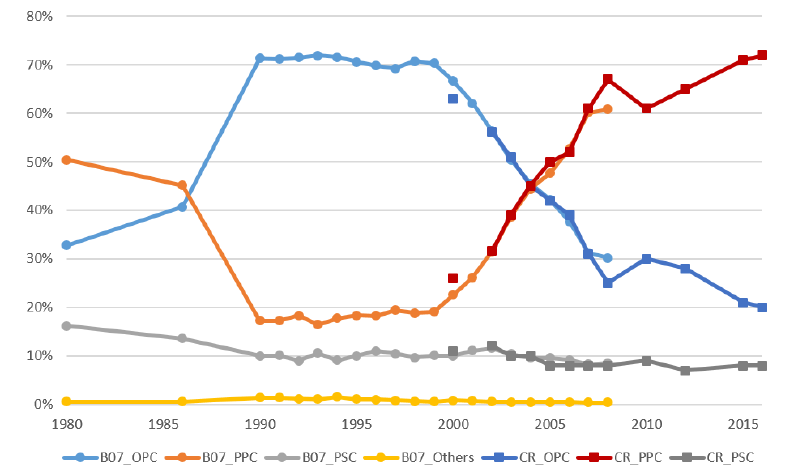
Figure D6. Proportions of cement production by type. B07: Bapat et al. (2007), CR: CRISIL (various years). OPC: ordinary Portland cement, PPC: Portland pozzolana cement, PSC: Portland slag cement.